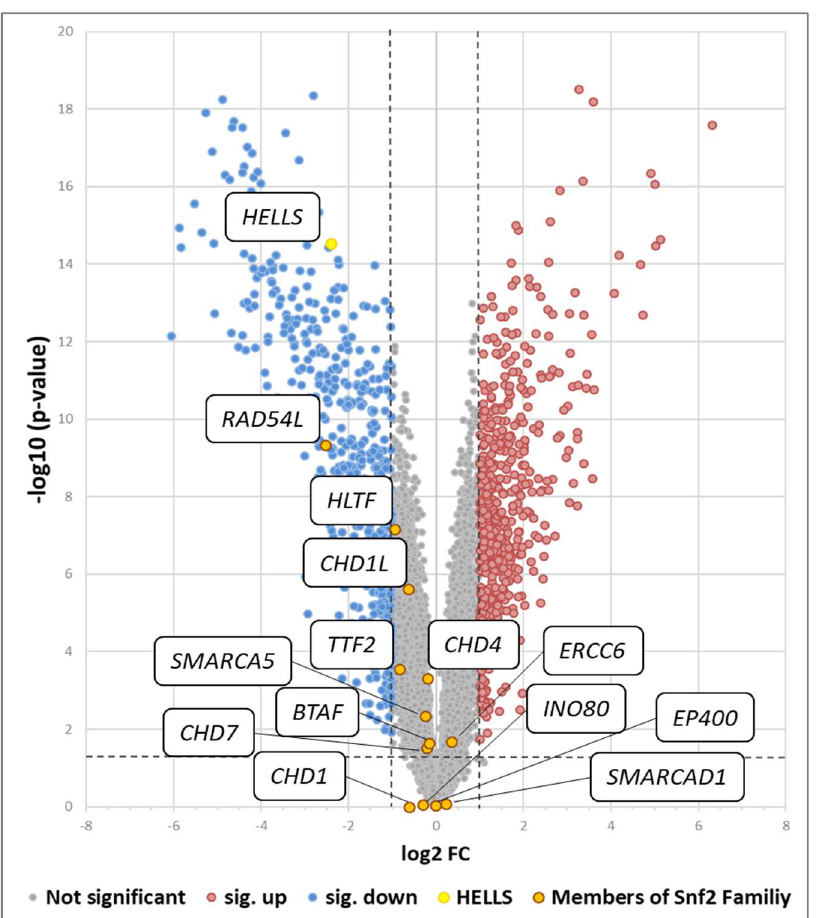
Figure 3. P53-mediated HELLS repression is largely selective within the SNF2-like helicase family. Volcano plot shows 9129 transcripts identified in HepG2 cells by Affymetrix microarrays. After 24 h Nutlin-3a treatment, 530 transcripts were significantly upregulated (colored in red) and 571 transcripts were significantly down regulated (colored in blue). (Horizontal dotted line p = 0.05; vertical dotted lines log 2 fold-change 1.0 or −1.0). mRNA levels of SNF2-like family members are highlighted in orange including HELLS in yellow.